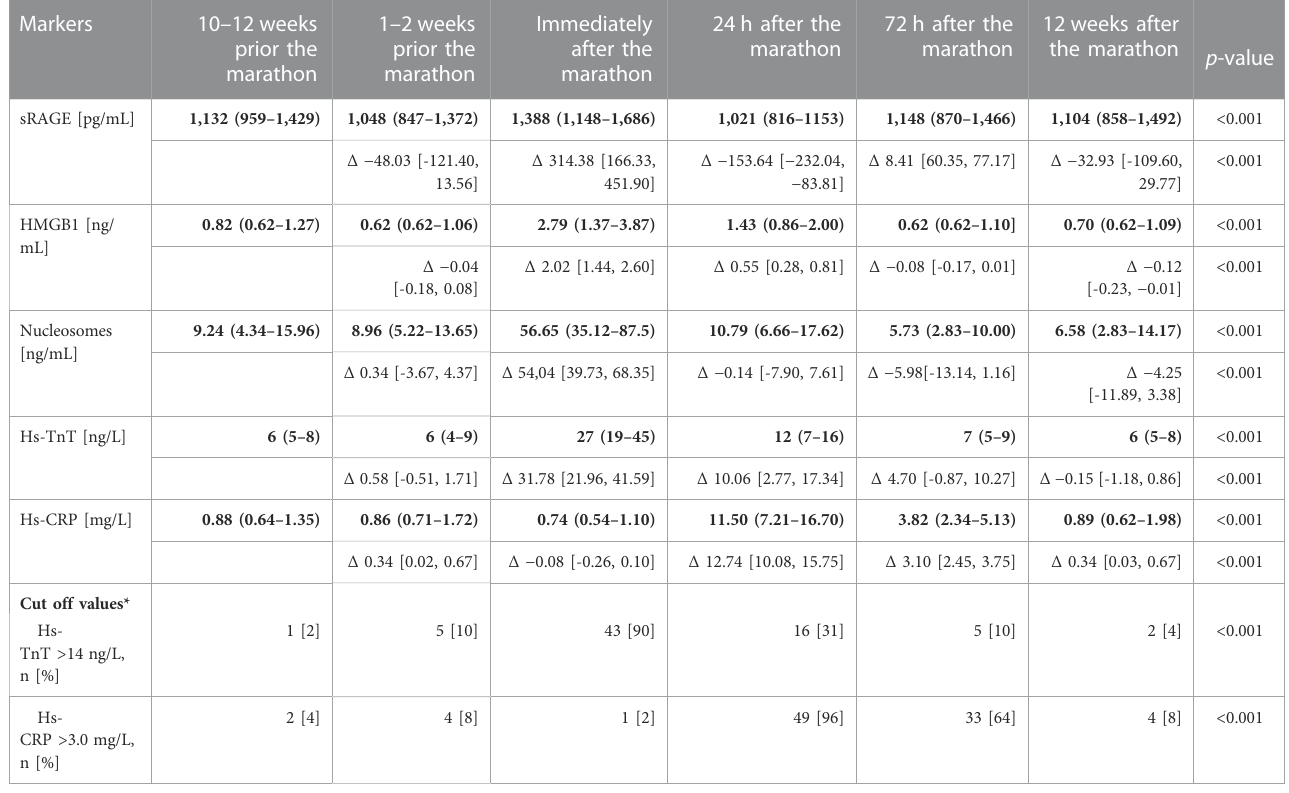
TABLE 2 HMGB1, sRAGE, nucleoseomes, hs-TnT, and hs-CPR concentrations over the study period. Markers 10 – 12 weeks prior the